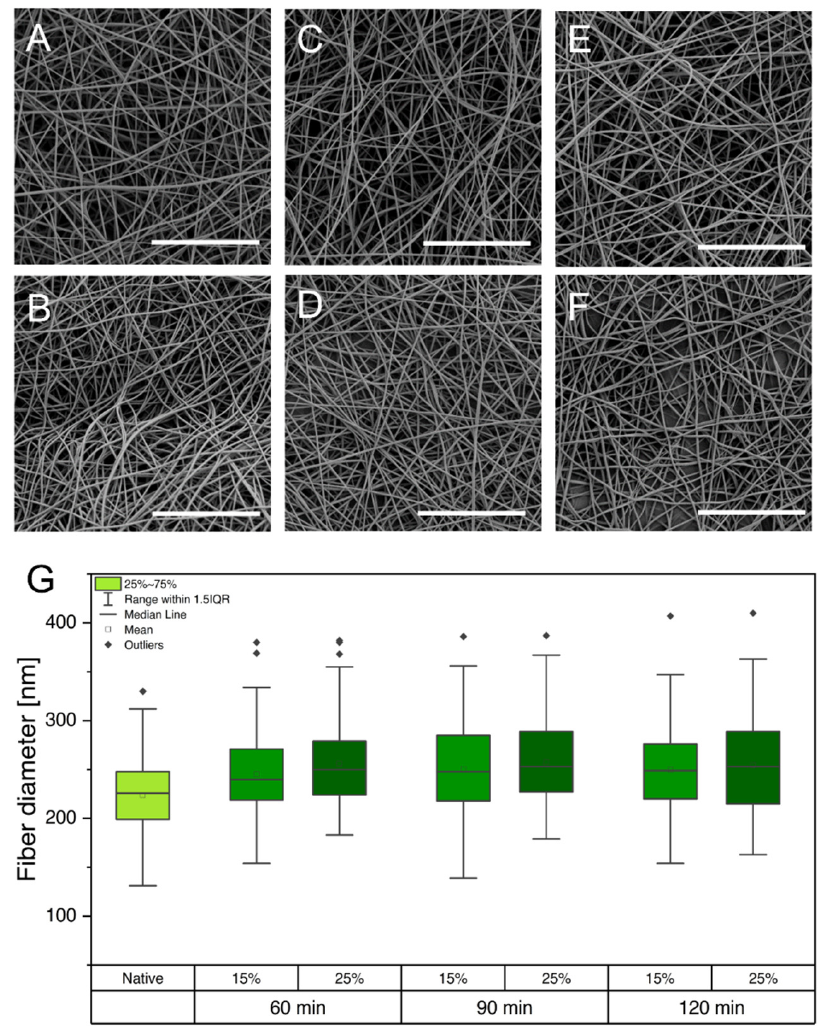
Figure 3. ( A – F ) Scanning electron micrographs showing gelatin fibers under various crosslinking conditions: 60 min, 15% ( A ); 60 min, 25% ( B ); 90 min, 15% ( C ); 90 min, 25% ( D ); 120 min, 15% ( E ); and 120 min, 25% ( F ). ( G ) Comparison of diameters of gelatin fibers that were exposed to different crosslinking conditions. Scale bars represent 20 µm.